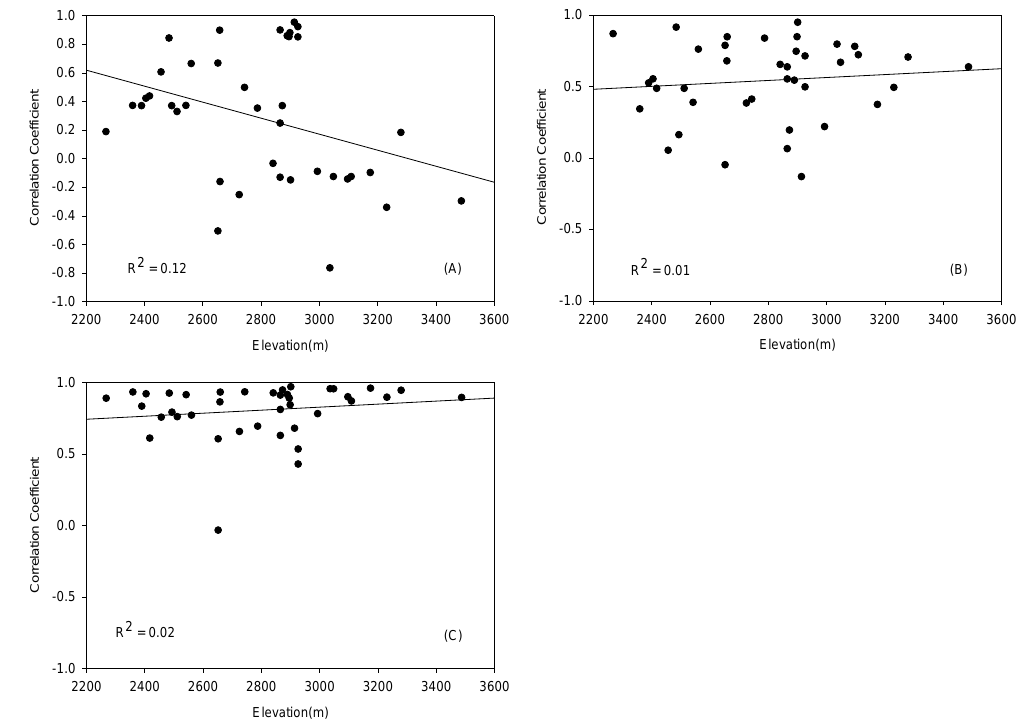
Fig. 8. Relationships between elevations and correlation between the three SWE products and SNODAS SWE plotted at the SNOTEL sites. Correlation of the SWE estimated from microwave imagers (A) , correlation of the SWE simulated with UEB forced with TRMM precipitation data (B) , and SWE simulated with the UEB with MPE as input precipitation data set (C) .